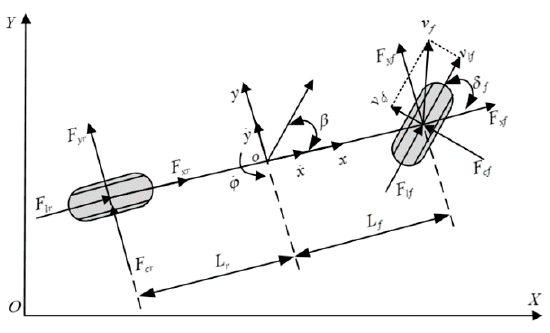
Figure 2. Schematic of the single-track model.